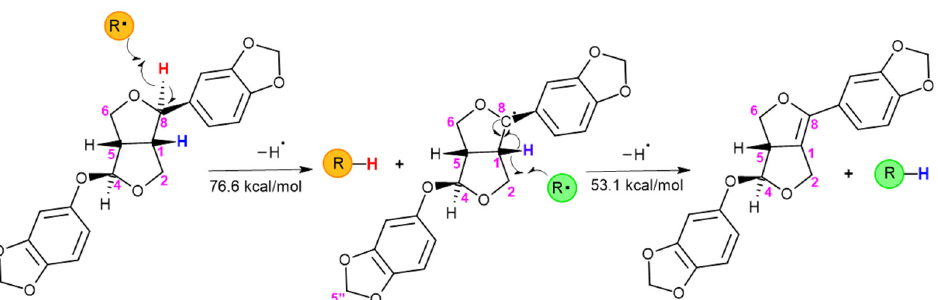
Figure 2. The proposed mechanism of sesamolin stabilized the free radical via hydrogen atom transfer based on Bond Dissociation Energy value. The abstraction of allylic hydrogen atom at C-8 to free radical generates sesamolin radical and stabilizes radical compound. Then the donation of a hydrogen atom at C-1 of sesamolin radical forms a double bond leading to the stabilization of the derived compound. Thus, sesamolin was able to donate two hydrogen atoms. The picture was drawn using MarvinSketch version 21.1.